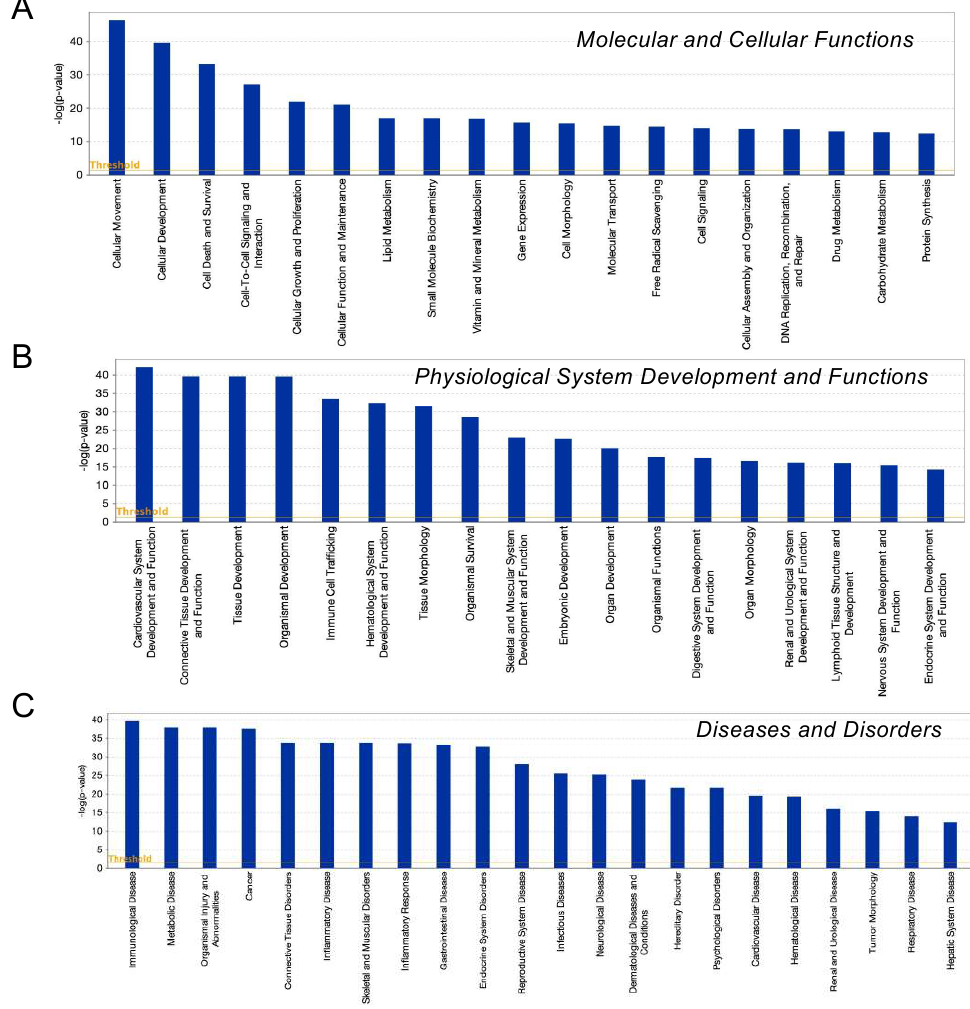
Figure 6. IPA analysis of DEGs. Overlapping canonical 25 upregulated pathways were estimated by the IPA analysis. Among three biophysiological categories, molecular and cellular functions ( A ), physiological system development and function ( B ), and diseases and disorders ( C ), the bars correspond to the top 18–22 canonical pathways that surpassed the Ingenuity statistical threshold using the Benjamini–Hochberg multiple testing correction of Fisher’s exact test.